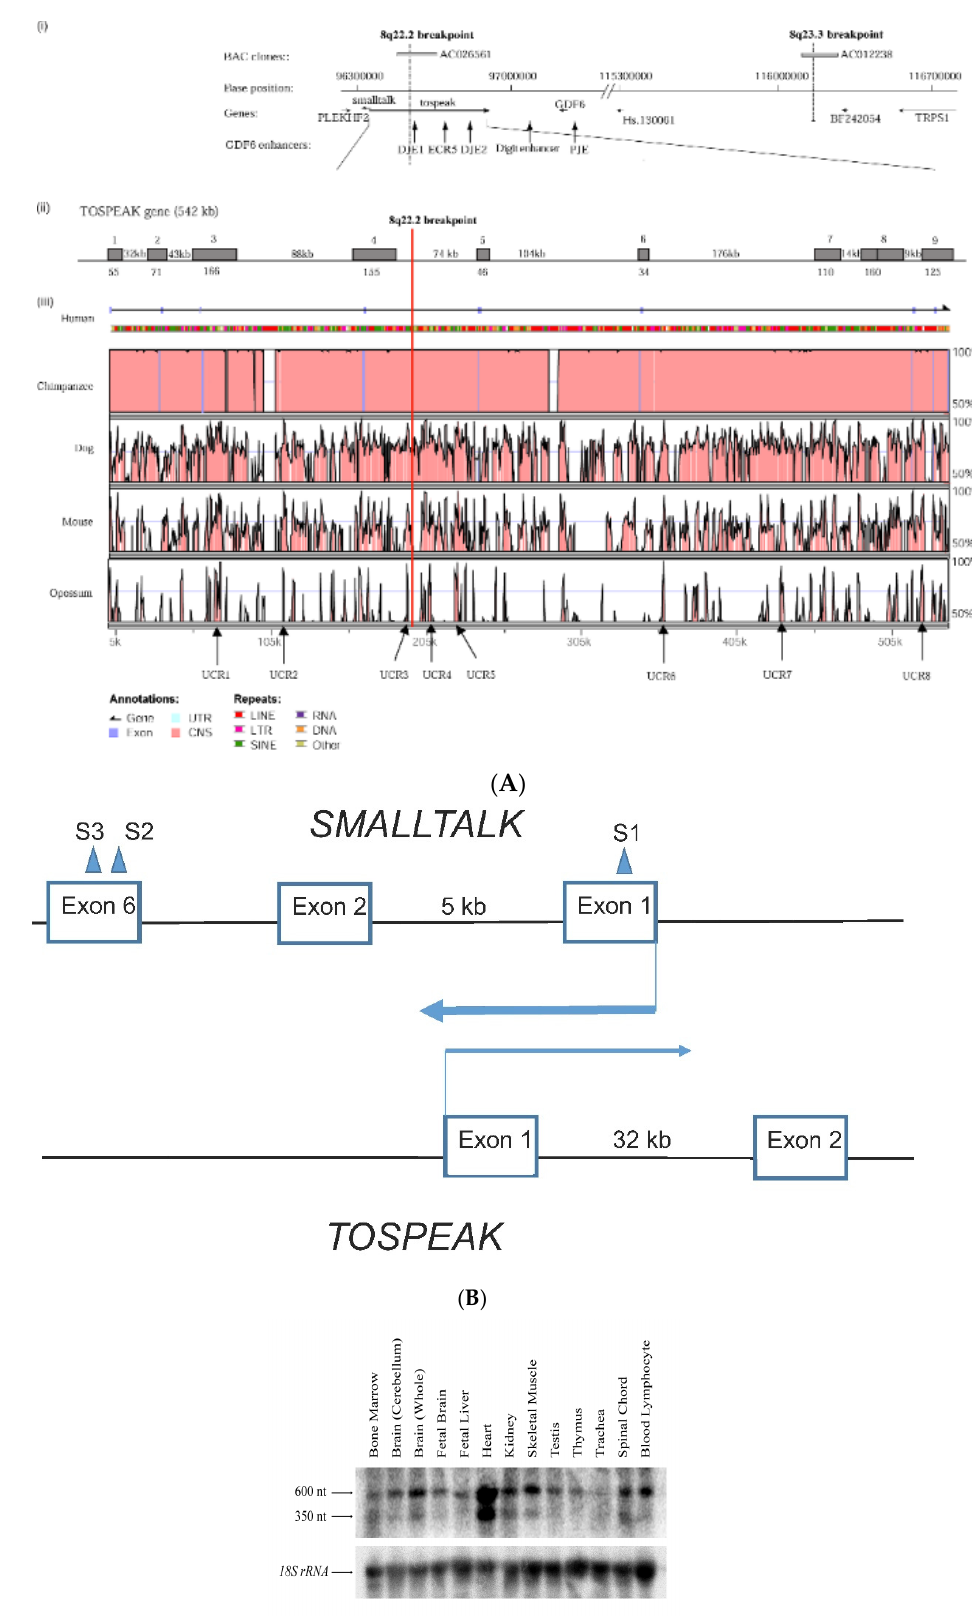
Figure 3. TOSPEAK gene characterisation: ( A ) Comparative genomic analysis of the TOSPEAK locus ( i ) Schematic view of the genomic region spanning inv(8) (q22.2q23.3) breakpoints in the SYNS4 family with congenital carpal tarsal coalition and progressive postnatal ossification and fusion of vertebral and ear joints. Genes (horizontal arrows), GDF6 enhancers (vertical arrows). ( ii ) TOSPEAK / C8orf37-AS1 gene structure with 8q22.2 breakpoint in the 4th intron. ( iii ) VISTA plot spanning TOSPEAK gene (exons marked blue) for multiple vertebrate species where strict selec- tion criteria applied for highly conserved regions (HCRs ≥ 200 bp ungapped alignment with > 90% identity). The human gene annotation was obtained from the Ensembl database and the repeat information was obtained from Repeat Masker (6 September 2009)). ( B ) Overlap between the TOSPEAK and SMALLTALK/C8orf37 genes. ( C ) Northern Analysis of TOSPEAK in human tissues.